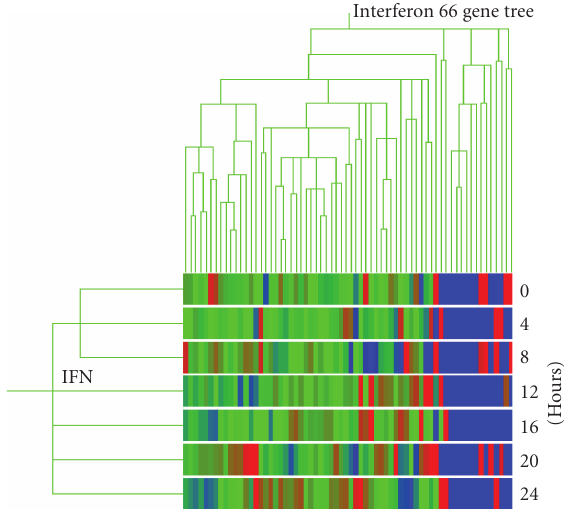
Figure 6: Hierarchical cluster of interferon 66 gene tree. Di ff erent expression of 66 interferon-related genes were analyzed by Gene Tree program. The expression of more than two thirds (red and blue) was changed, and about one third of the genes were not ex- pressed